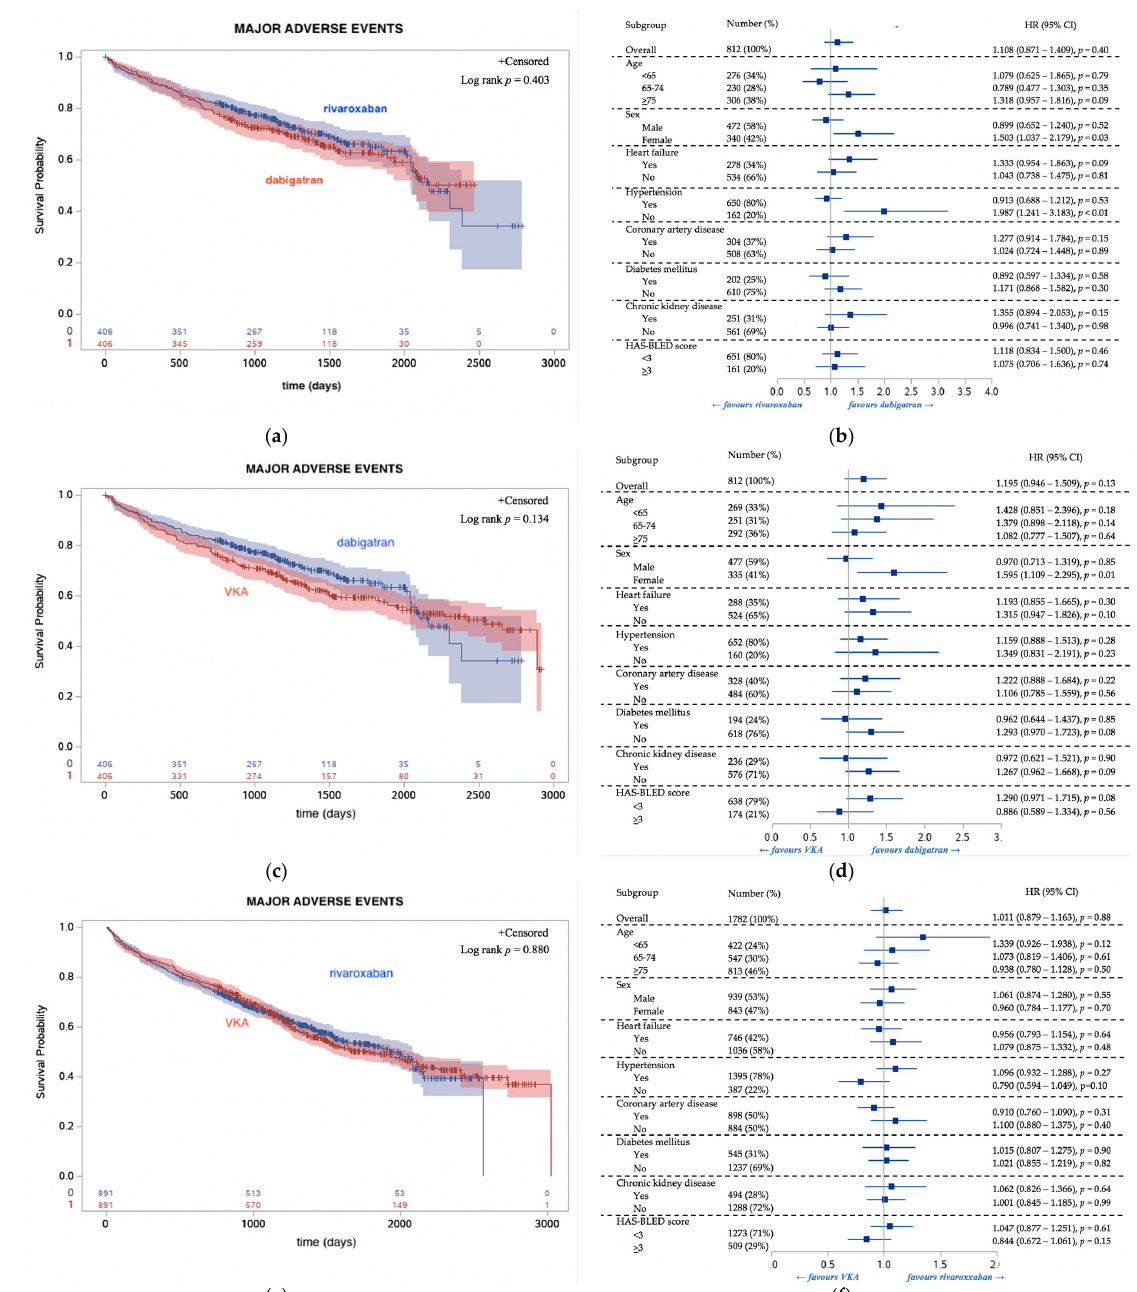
Figure 1. Kaplan–Meier analysis of time-to- major adverse events (left side, ( a , c , e )) and subgroup-specific hazard ratios with 95% confidence intervals for major adverse events (right side, ( b , d , f )) in patients treated with dabigatran vs. rivaroxaban (upper panel, ( a , b )) dabigatran vs. VKA (middle panel, ( c , d )) rivaroxaban vs. VKA (lower panel, ( e , f )) after propensity score matching. Abbreviations: CAD, coronary artery disease; CI, confidence interval; CKD, chronic kidney disease; DM, diabetes mellitus; HF, heart failure; HR, hazard ratio; HT, hypertension; VKA, vitamin K antagonist. Hazard ratios were generally consistent among subgroups (Figure 1) with a few ex- ceptions. For thromboembolic and hemorrhagic events, the increased risk with rivaroxa- ban treatment (vs. dabigatran) was observed in patients aged 75 or more. Coronary artery